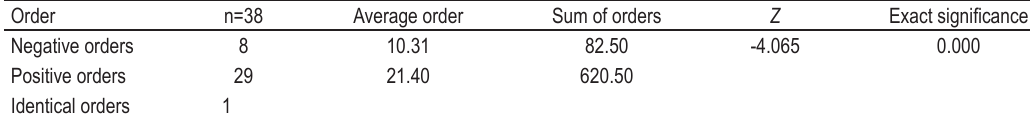
TABLE 1. The quality of life of elderlies measured by Wilcoxon signed-rank test (1 st measurement versus 6 th measurement)